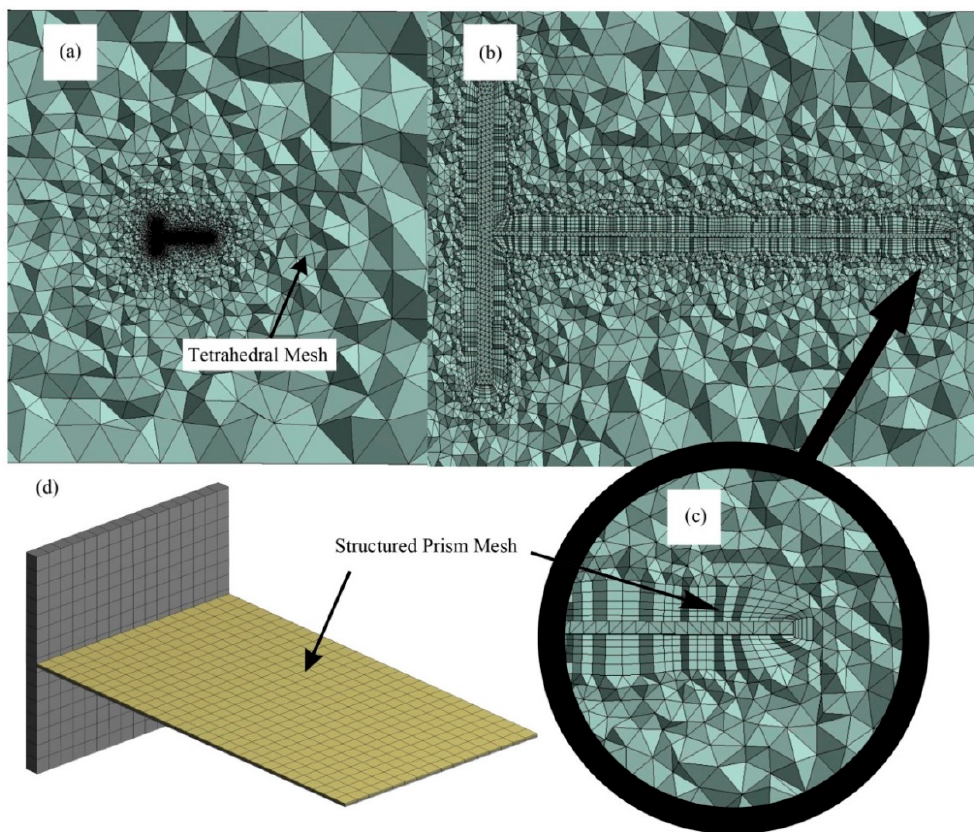
Figure 6. ( a ) Unstructured fluid domain mesh; ( b ) inflation layer near wall of model; ( c ) close-up on tip of model with inflation layer; ( d ) structured mesh on model.